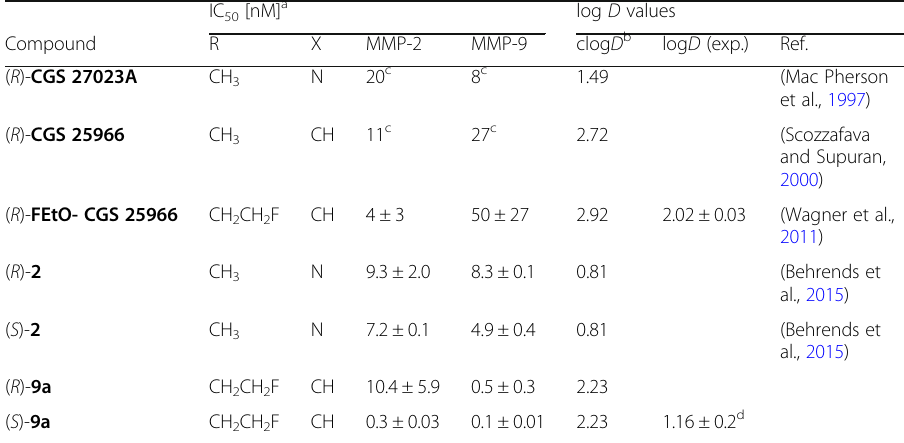
Table 2 MMP inhibition potencies and clog D (log D ) values of lead structures and target novel hydroxamic acids IC 50 [nM] a log D values Compound R X